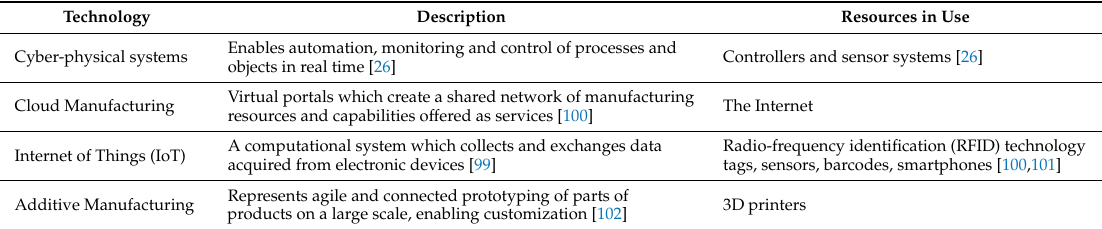
Table 5. Overview of the functional technologies of Industry 4.0. (Adapted from Kang et al., 2016